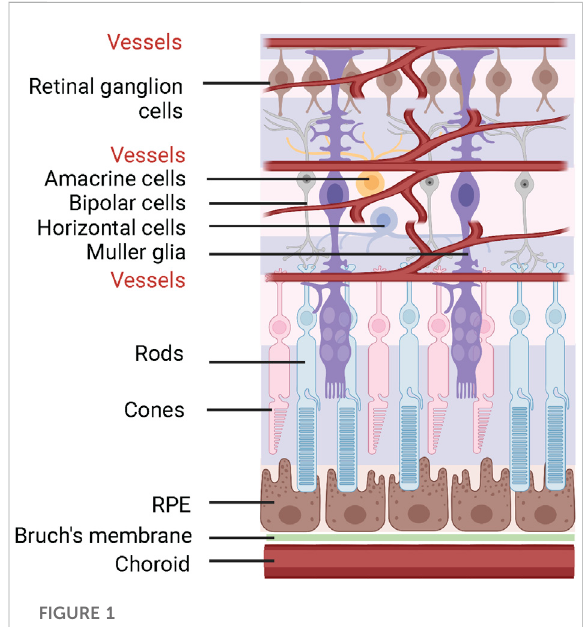
FIGURE 1 Schematics of retinal structure. The neural retina is supplied by retinal and choroidal vasculature. Photoreceptors (rods and cones) are supported by RPE and Müller glia cells. The fi gure was generated using Biorender (license #